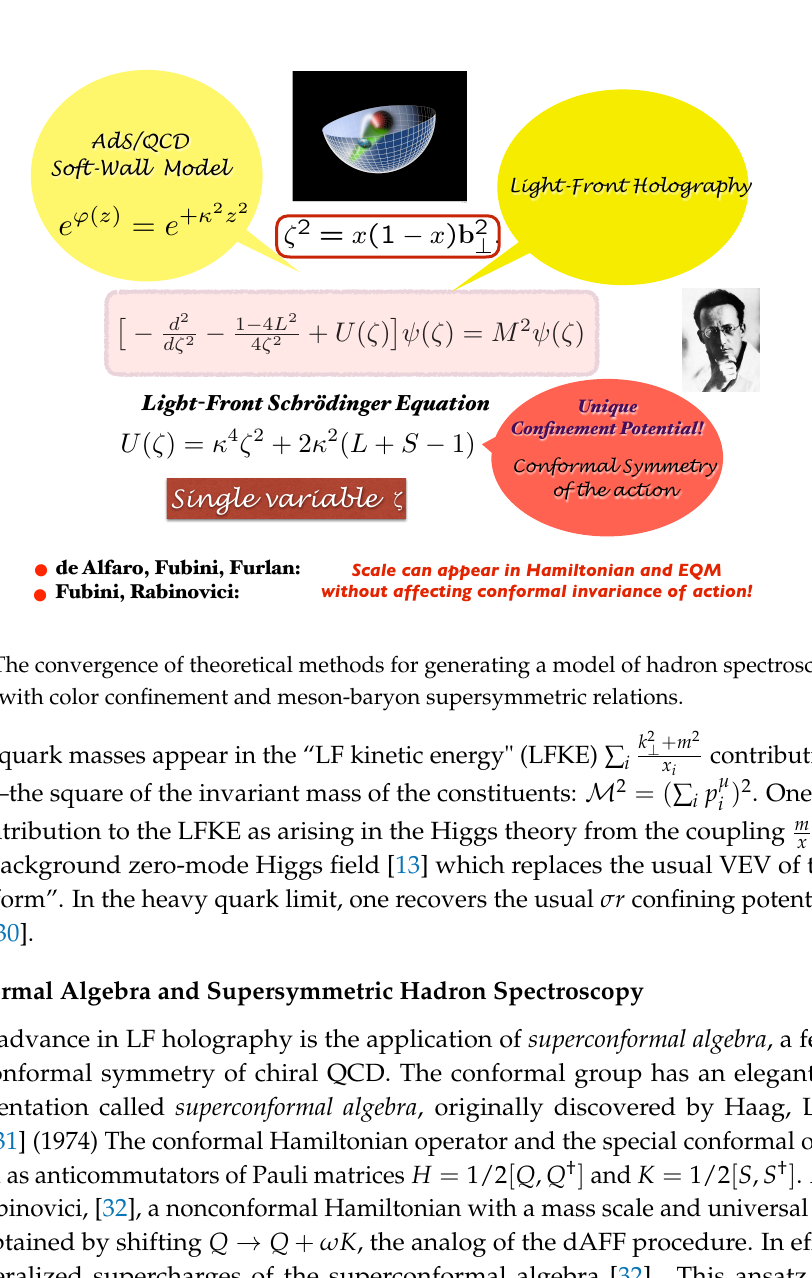
+ m 2 k 2 contribution to the ⊥ x i